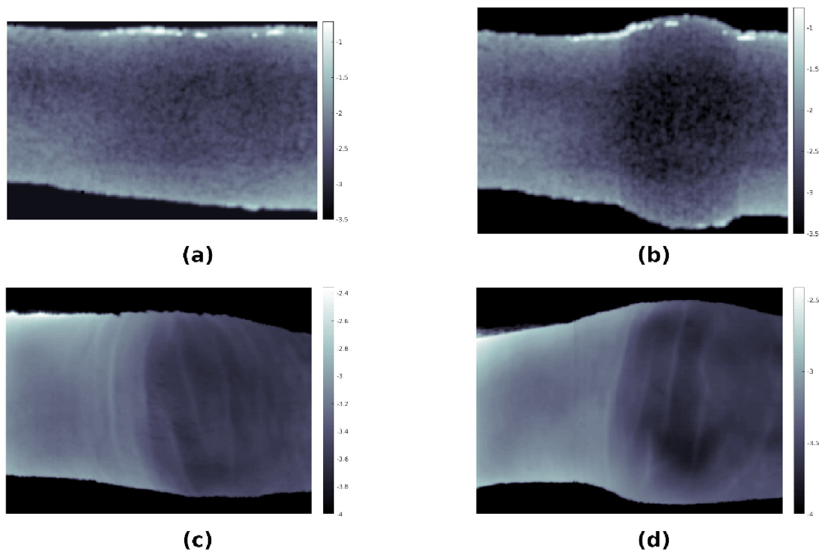
Figure 10. Transmittance images (logarithmic scale) obtained using simulations ( a , b ) and custom- made laboratory hyperspectral imaging (HSI) system ( c , d ) for a healthy finger ( a , c ) and a finger affected by rheumatoid arthritis ( b , d ). All images include data integrated for wavelengths between 650 nm and 760 nm, a spectral range found to be most sensitive to changes due to arthritic disease.